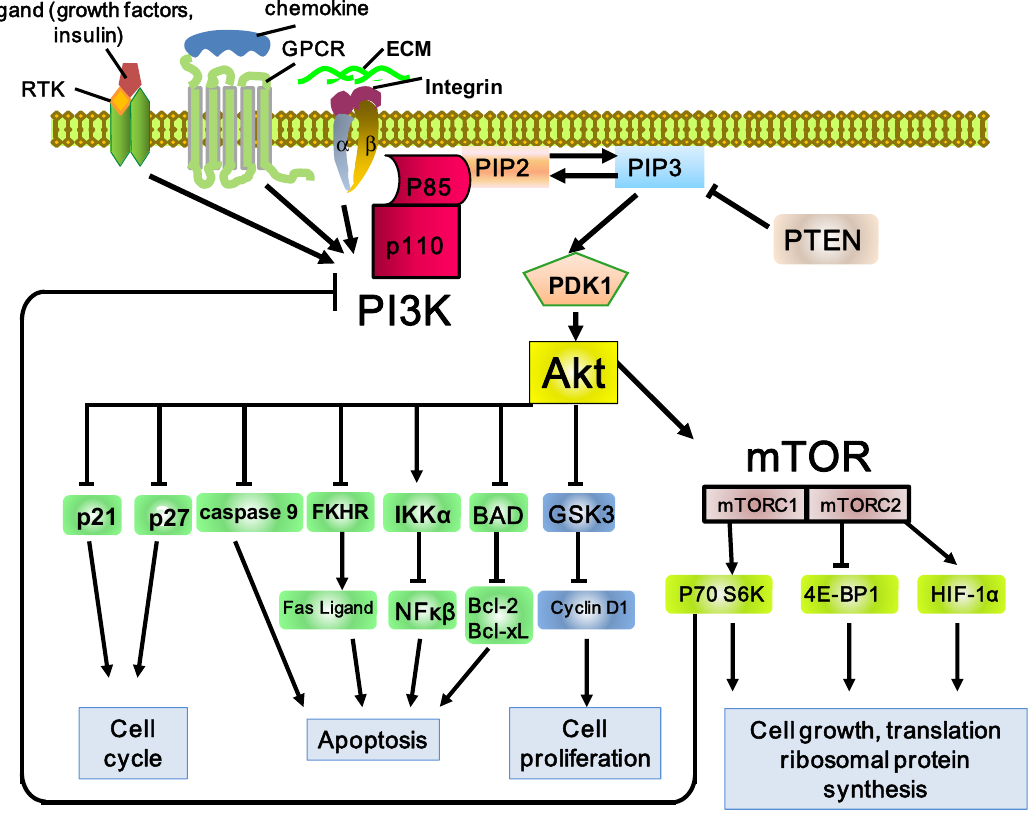
Figure 1. Schematic representation of the PI3K/Akt/mTOR pathway. The PI3K pathway involves many factors, including the binding of receptor tyrosine kinase (RTK), G-protein-coupled receptors (GPCR), and GTP-binding proteins to adaptor proteins. PI3K consists of the catalytic subunit, p110, and the regulatory subunit, p85. PI3K phosphorylates PIP2 (phosphatidylinositol 3,4-bisphosphate) and produces PIP3 (phosphatidylinositol 3,4,5-trisphosphate). PIP3 then activates 3-phosphoinositide-dependent kinase 1 (PDK1) and its major downstream effector, Akt. Phosphorylation of Akt promotes cell proliferation, survival, migration, and differentiation. Phosphatase and tensin homolog (PTEN) dephosphorylates PIP3 and inhibits activation of Akt by PIP3. Phosphorylation of Akt induces the activation of one of the major downstream effectors, mTOR (mammalian target of rapamycin). mTOR phosphorylates S6K1 and 4EBP1, directly leading to increased translation and synthesis of cell-cycle-regulating and ribosomal proteins. Stimulatory events are indicated by arrows and inhibitory events are indicated by lines ending in flat